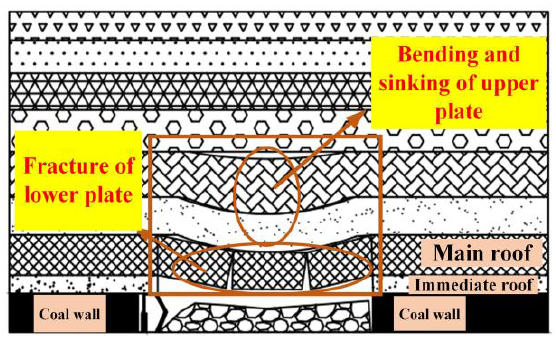
Figure 3. Periodic weighting.